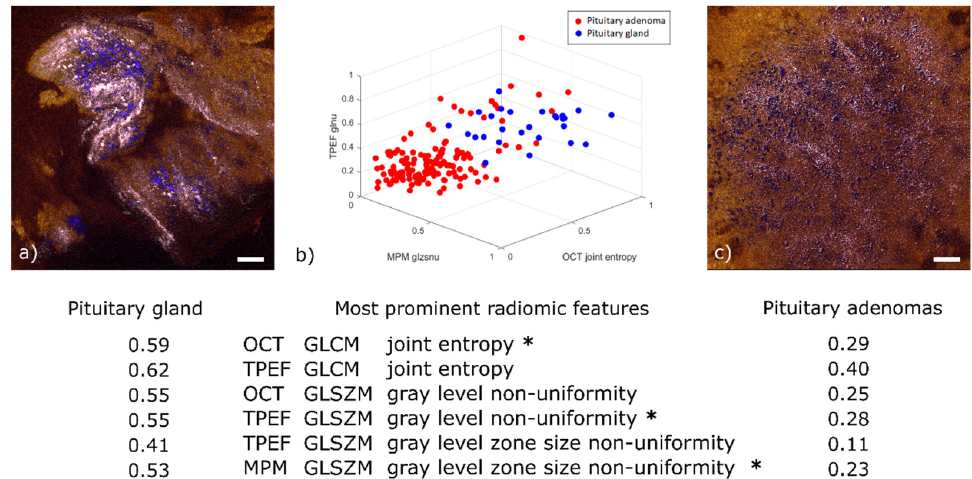
Figure 6. Radiomic analysis and comparison of representative pituitary gland and pituitary adenoma images. ( a ) OCT-MPM overlay of pituitary gland showing prominent cell nests (colored in blue) with surrounding connective tissue (colored in pink). ( b ) 3D scatter plot of three out of the six most prominent radiomic features. The selected features are marked with an asterisk in the table below. The table displays the average value for each of the six prominent features in pituitary gland and pituitary adenomas. All values normalized by their respective maximum. ( c ) Representative OCT-MPM overlay of pituitary adenoma (mammosomatotroph) displaying the loss of structure in connective tissue (color-coded in pink) and distribution of cells (color-coded in blue). Scale bars indicate 50 µm.